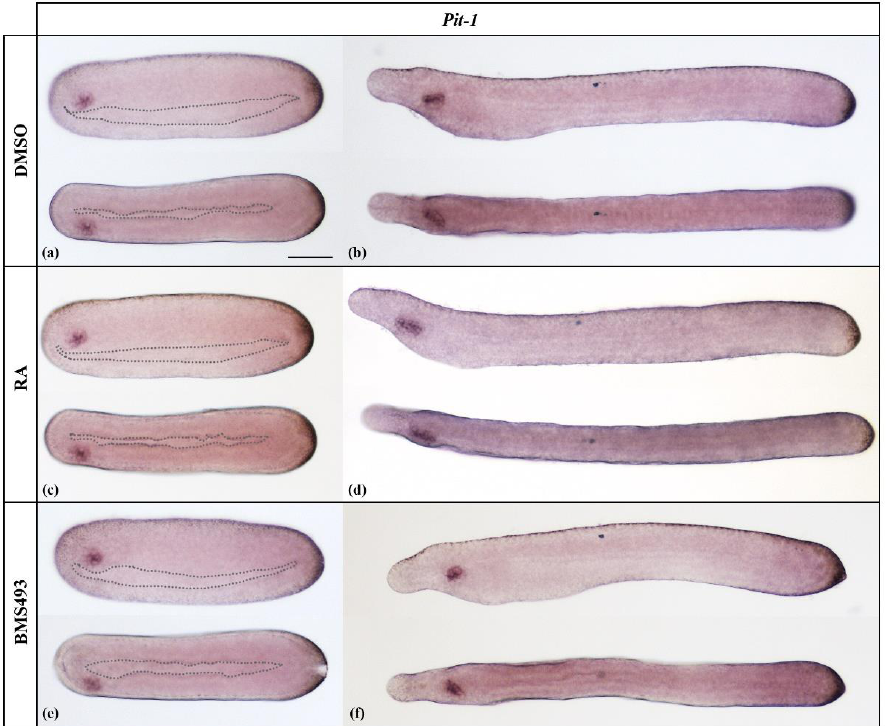
Figure 1. Expression of Pit-1 in N4- and T1-stage Branchiostoma lanceolatum embryos. ( a , b ) Control embryos (DMSO-treated). ( c , d ) Retinoic acid (RA) signaling activation with all- trans retinoic acid (RA). ( e , f ) RA signaling inhibition with the inverse agonist BMS493. Pit-1 is expressed exclusively in the preoral organ, and this expression is unaffected by the treatments. Whole mount embryos are shown in lateral (top) and dorsal (bottom) views; the anterior is to the left. Dotted outlines mark the borders of the gut in N4 neurulae. The scale bar in ( a ) is 50 μm and is valid for all panels.